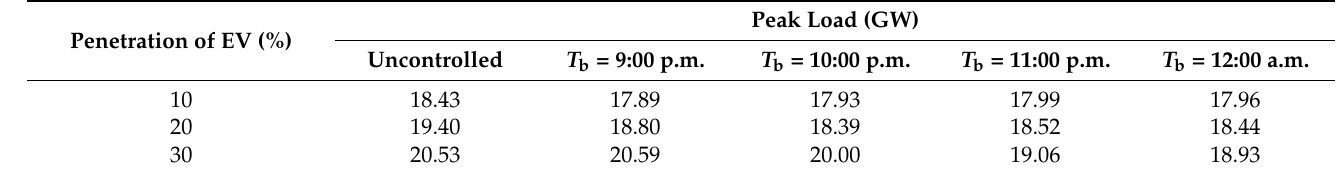
Table 5. Load demand of the PEA under different scenarios when R i = 0.5 and uniform distribution of S i